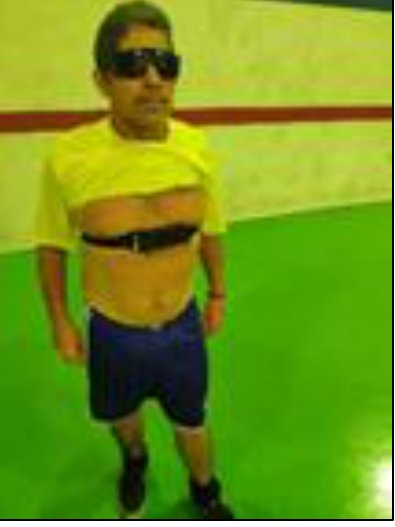
Figure 6: Elastic belt with vibrating devices placed in the athlete's chest